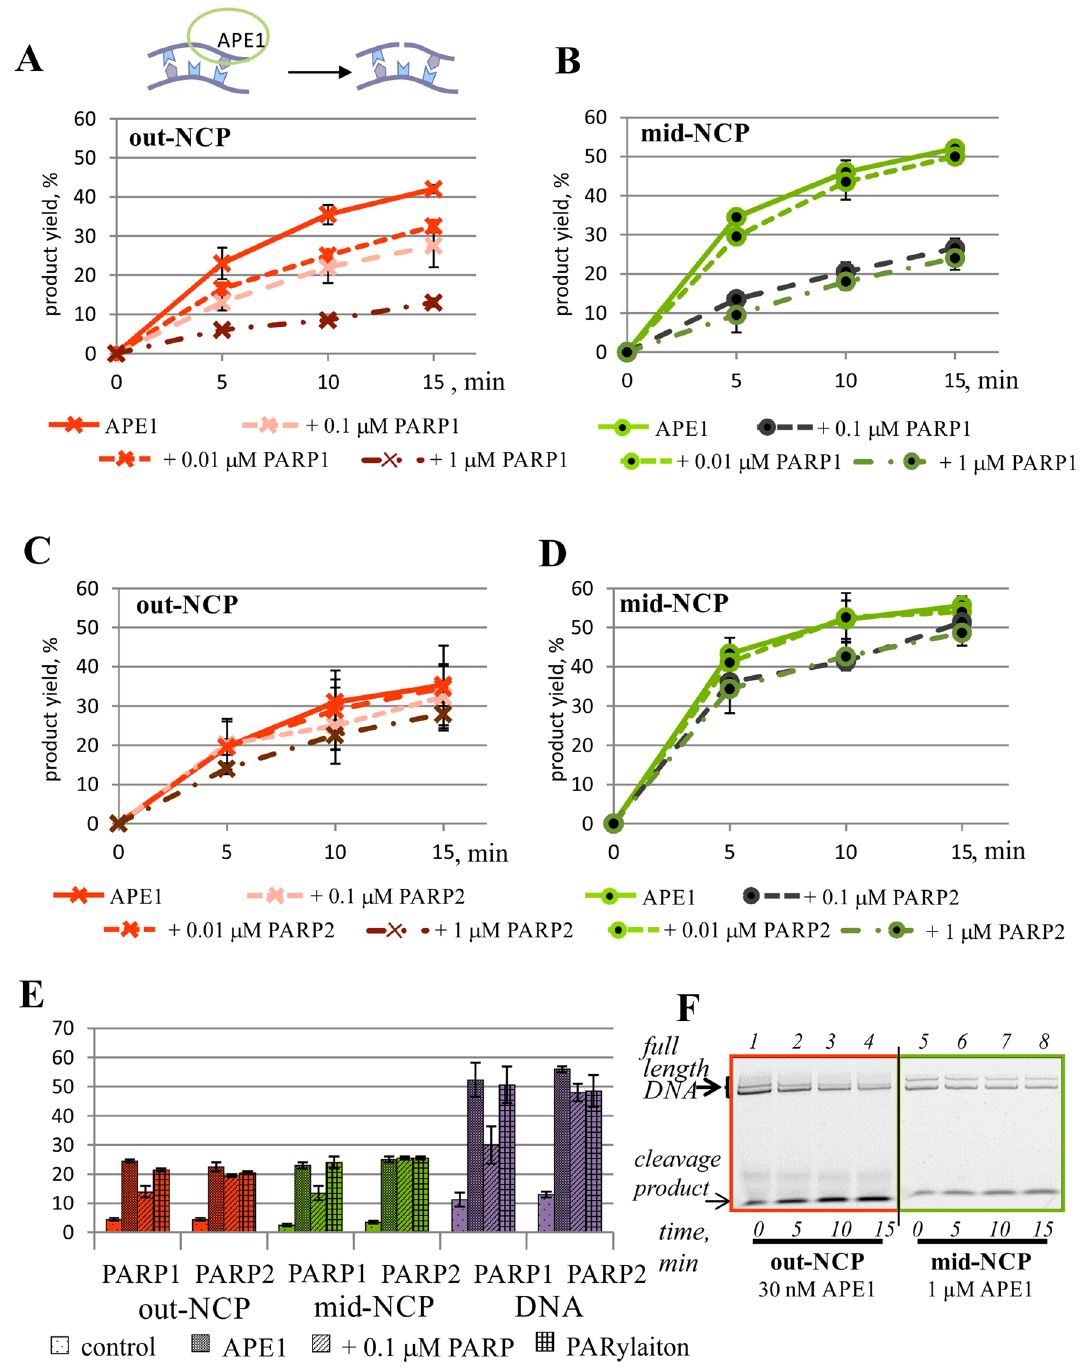
Figure 3. The kinetic assay of APE1 activity towards an outward- or midward-oriented AP site in the NCP context in the presence of PARP1 or PARP2. ( A ) Kinetics for out-NCP and PARP1. ( B ) Kinetics for mid-NCP and PARP1. ( C ) Kinetics for out-NCP and PARP2. ( D ) Kinetics for mid-NCP and PARP2. ( E ) The influence of PARylation catalysed by PARP1 or PARP2 on the activity of APE1 towards AP site–containing DNA or NCP- based substrates. The ‘control’ label corresponds to the spontaneous cleavage of the AP site; ‘APE1’ indicates the specific cleavage by APE1 under the reaction conditions; ‘+ 0.1 μM PARP’ denotes the specific cleavage in the presence of the indicated protein; and ‘PARylation’ represents the specific cleavage in the presence of the indicated protein and 400 μM NAD + . The data are presented as an average of at least three independent experiments and are shown as the mean ± SD. The reactions were carried out as described in “Materials and methods”. All graphs are normalised to spontaneous cleavage of an AP site under the experimental conditions. ( F ) Separation of the products (on a 10% denaturing polyacrylamide gel) of the reaction of 0.1 μM 5 ′ -FAM– labelled AP-NCP with APE1 under the indicated experimental conditions. In all cases, the APE concentrations of 0.03 and 1 μM were chosen for the reaction conditions involving substrates out-NCP and mid-NCP,